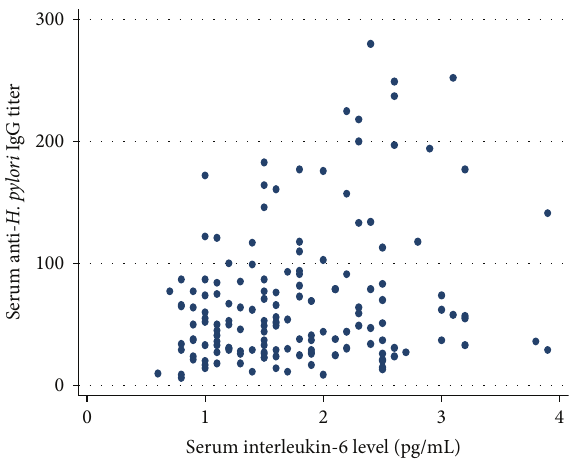
Figure 1: Correlation between serum interleukin-6 and anti- H. pylori IgG titers among men ( 𝑟 = 0.27 , 𝑃 = 0.045 , and 𝑛 = 54 ).